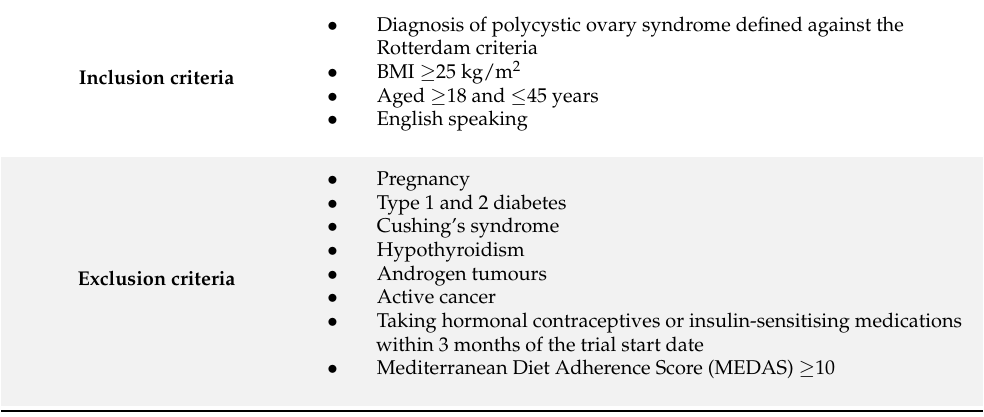
Table 1. Participant inclusion and exclusion criteria.